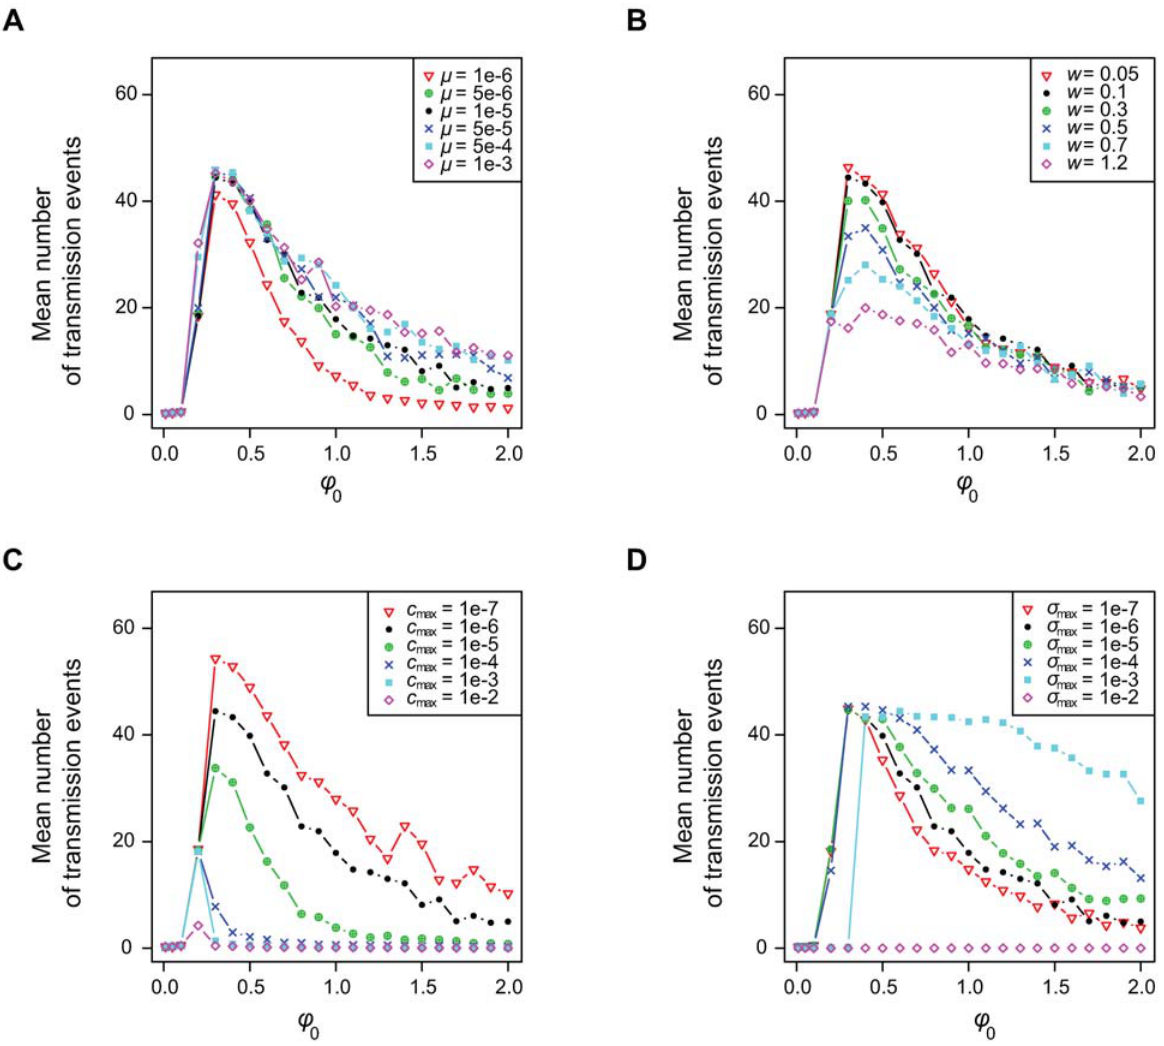
Figure 3. Effects of parameter variations on infection fitness. Effect of the initial replication rate (x-axis) on the infection fitness for different values of A) the mutation rate m , B) the mutation width for the replication rates w , C) the maximum proliferation rate of immune cells c max , and D) the maximum killing rate of immune cells s max . Different parameter values are shown using different colour symbols (see the box in each panel) and the default case is in black. For further details about the simulations see the main text and Text S1.